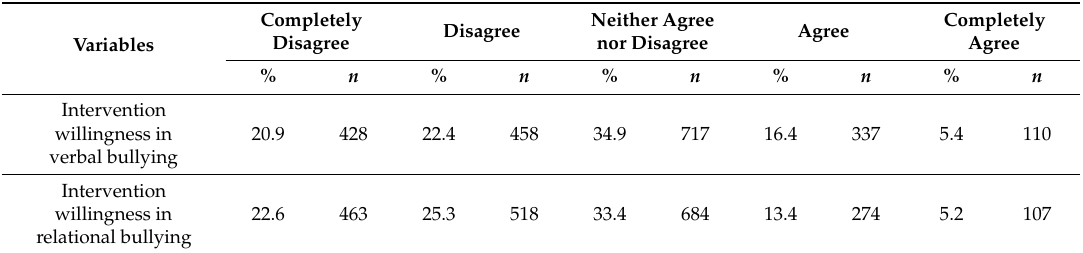
Table 1. Frequency rates of students’ willingness to intervene in verbal and relational bullying.